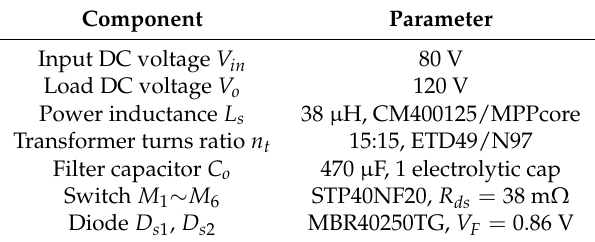
Figure 10. The layout of a 200 W S-DAB laboratory prototype. Table 4. Specifications of a 200 W S-DAB